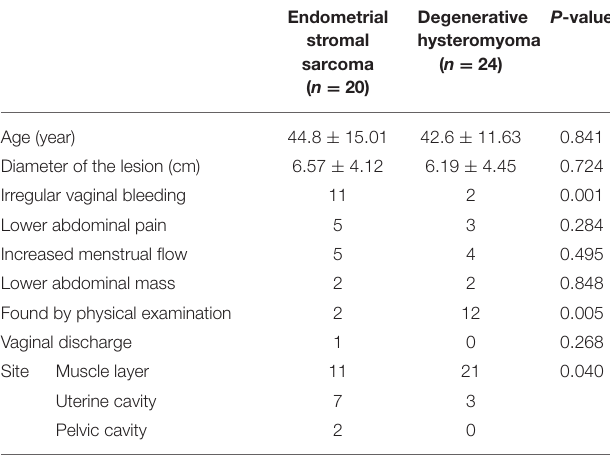
TABLE 1 | The clinical characteristics in the